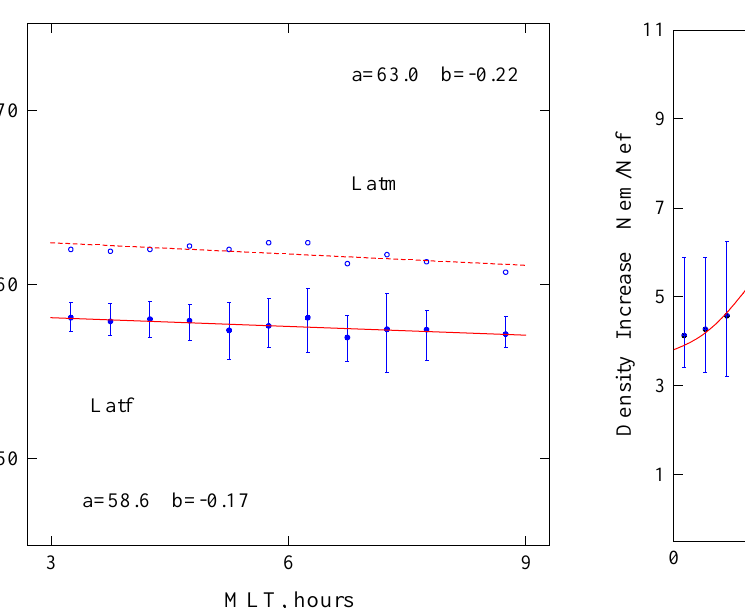
Fig. 6. Relative density increase in the polar cliff as function of geographic longitude. The geographic longitude is indicated on the abscissa, the relative density increase on the ordinate. The median (blue dots) and the upper and lower quartiles (blue bars) of this latter parameter were determined for each 15 ◦ -wide interval of the geographic longitude. A combination of sin and cos functions was fitted to the median values (solid red line; see Eq. 7). The location of the geomagnetic pole is indicated by an arrow. Note that the results presented in this figure refer to an altitude of 400km; see text for